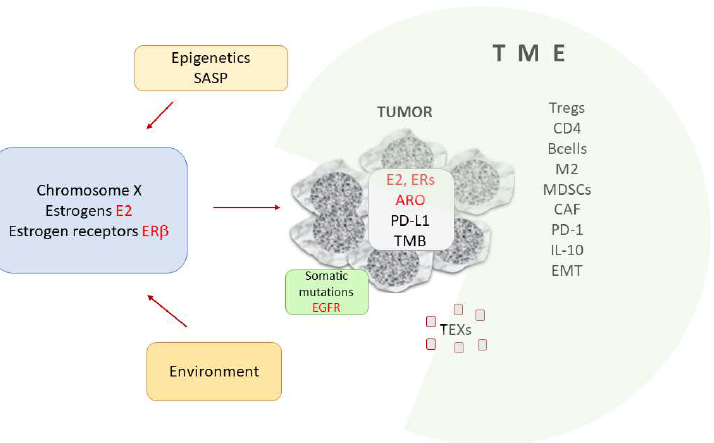
Figure 5. Simplified summary of the importance of estrogens in tumor immunity. The nature of the tumor environment (TME) is crucial in cancer progression. Many cells (Tregs, Bregs, CD4 and CD8 cells, MDSCs, DCs and cells with PD-1 expression), EMTs and mediators contribute to the immunosuppressive function of the TME. Estrogens, estrogen receptors and enzymes (aromatases) are capable of modifying immune anticancer response. Hormonal balance depends on genetic factors connected with the X chromosome, epigenetics and the environment. Estradiol and estrogen receptor beta are the main players in systemic and local regulation of carcinogenesis, tumor progression and modulation of immunity. Abbreviations: ARO: aromatase; CAF: cancer-associated fibroblast; E2-17 β : estradiol; EGFR: epidermal growth factor receptor; ERs: estrogen receptors: EMT: epithelial–mesenchymal transition; M2- type 2 macrophages, MDSCs: myeloid-derived suppressor cells; PD-1 – programmed death, PD-L1: programmed death ligand 1; SASP: senescence-associated secretory phenotype: TEXs: tumor-derived exosomes; TMB: tumor mutational burden; TME: tumor microenvironment, Tregs- regulatory